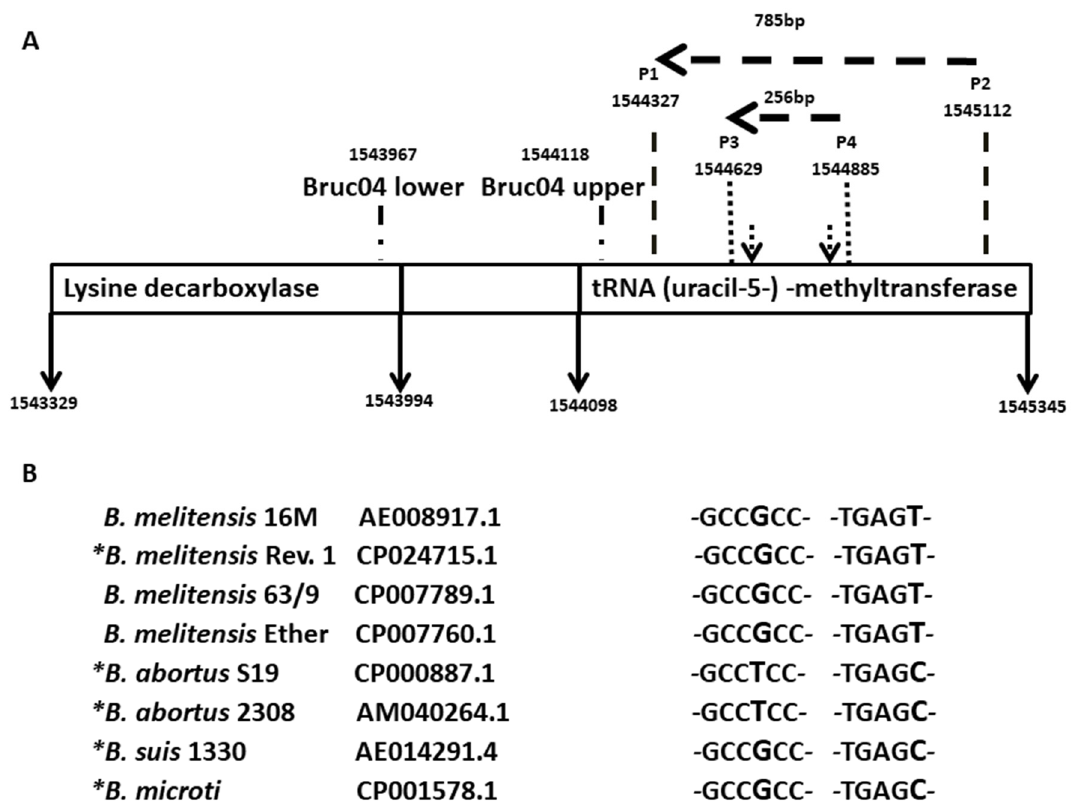
Figure 2. ( A ) Schematic presentation of the B. melitensis strain 16M tRNA (uracil-5) methyltransferase region (arrows indicate locations in the chromosome of ORFs and primers). The size of the first amplicon (785 bp) and nested PCR product (256 bp) as well as direction of gene transcription are indicated by broken arrows. Note, tRNA (uracil-5) methyltransferase is linked to an MLVA Bruc04 sequence. P stands for a primer. SNP locations on the nested PCR amplicon are indicated by short vertical broken arrows. ( B ) The specific tRNA (uracil-5) methyltransferase sequence which aligns with the corresponding SNPs and accession numbers are given. Star (*) stands for a reverse complementary sequence in comparison to that of B. melitensis 16M. SNPs are depicted by letters with an increased font size.